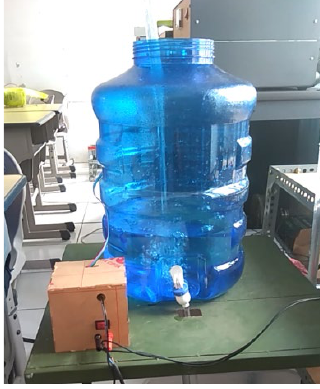
Figur e 25. Setpoint testing the lower limit of